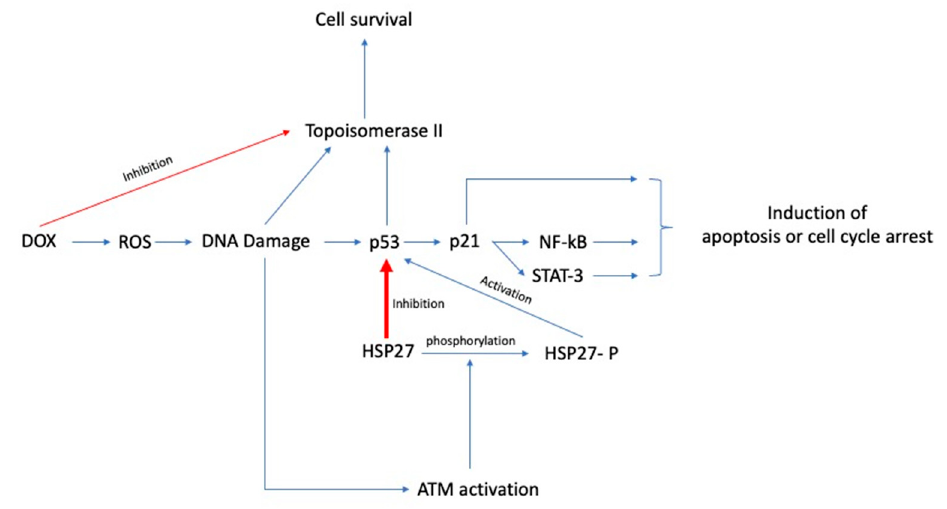
Figure 5. Summary of the proposed mechanisms by which Hsp27 induces doxorubicin chemoresistance. Hsp27 overexpression or overactivation results in inhibition of p53, a key molecule involved in doxorubicin induced apoptosis and cell cycle arrest. Key: DOX, doxorubicin; ROS, reactive oxygen species; STAT3, signal transducer and activator of transcription 3; NF-kb, nuclear factor kappa-light-chain-enhancer of activated B cells; ATM, ataxia-telangiectasia mutated kinase.